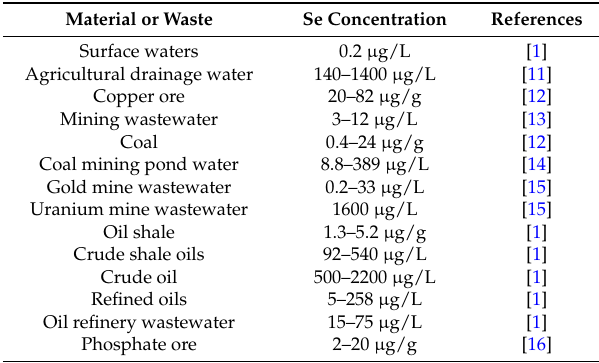
Table 2. Concentration of selenium in different